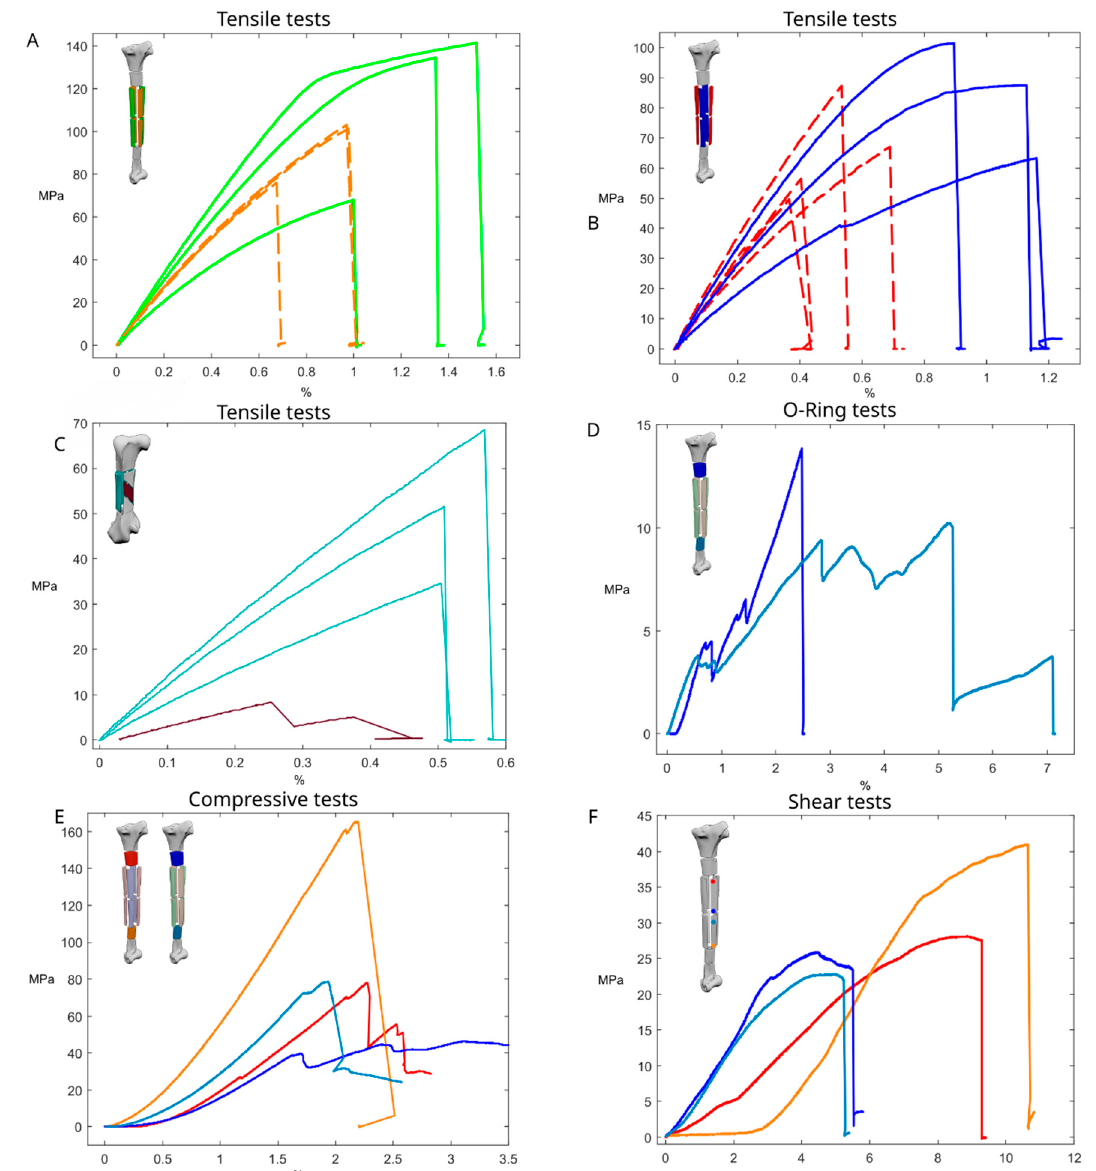
Figure 5. Mechanical tests. ( A ) Stress–strain curve of the tensile tests on the lateromedial regions of the tibial shaft (full line, green); stress–strain curve of the tensile tests on the frontal-caudal regions of the tibial shaft (dashed line, orange). ( B ) Stress–strain curve of the tensile tests on the wetted samples of the tibial shaft (full line, blue); stress–strain curve of the tensile tests on the dried-out samples of the tibial shaft (dashed line, red). ( C ) Stress–strain curves of the samples obtained from the tibial shaft; in red the proximal region of the shaft, in blue the frontal mid-shaft sample, in light blue the lateral mid-shaft sample, and in orange the distal shaft sample. ( D ) Stress–strain curve of the O-ring samples obtained from the ostrich tibia; in dark blue the proximal region, and in light blue the distal region. ( E ) Stress–strain curves of the compression tests of samples from the ostrich tibia; in dark blue the wetted proximal region, in light blue the wetted distal region, in red the dried proximal region, in orange the dried distal region. ( F ) Stress–strain curve of the tensile tests of sam- ples obtained from the femur, samples aligned to the long axis of the femur (full line, light blue); stress–strain curve of the tensile tests on the sample aligned at 45° with respect to the long axis of the femur (full line, brown).